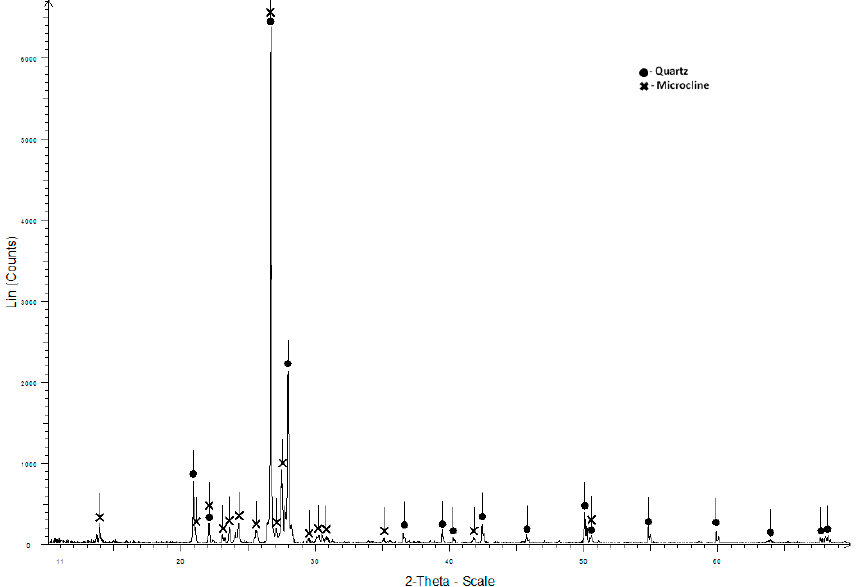
Figure 5. X-ray diagram of the granite crushed stone.